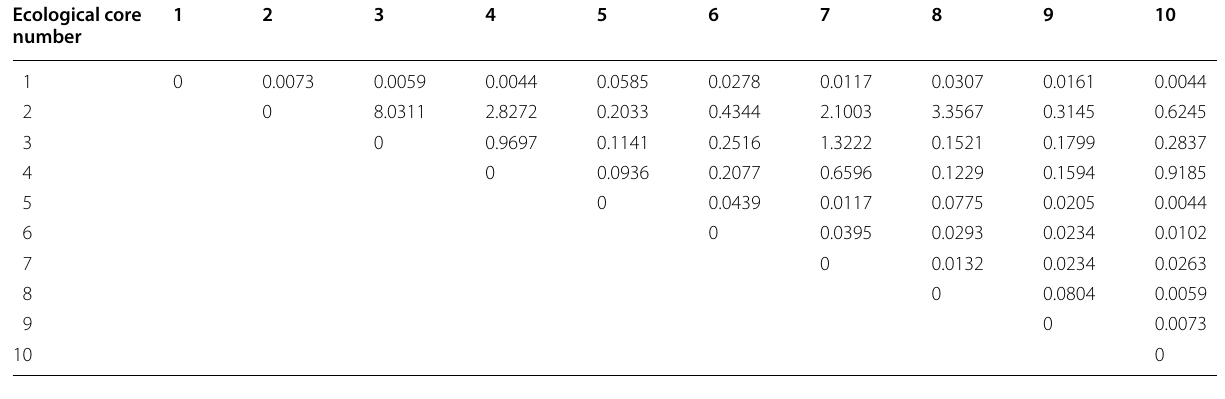
Table 3 Calculated interaction matrix of each ecological source based on the gravity model. Ecological corridors with an interaction intensity greater than 0.3 were identified as important corridors Ecological core number